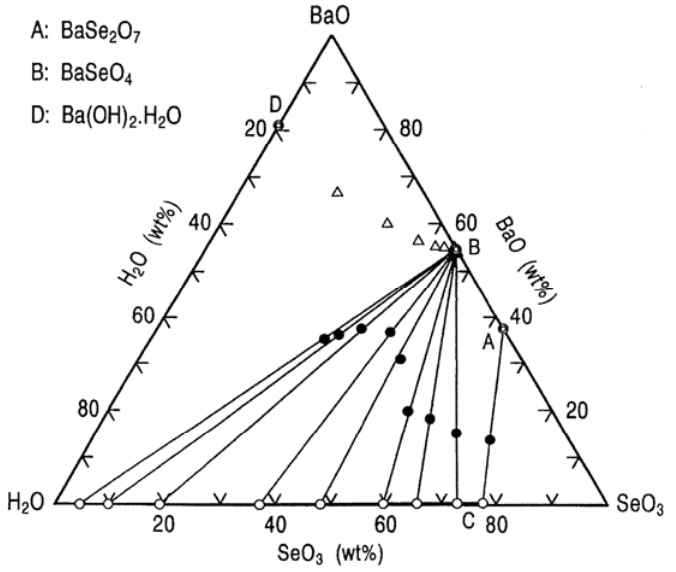
-H O system at 25 3 2